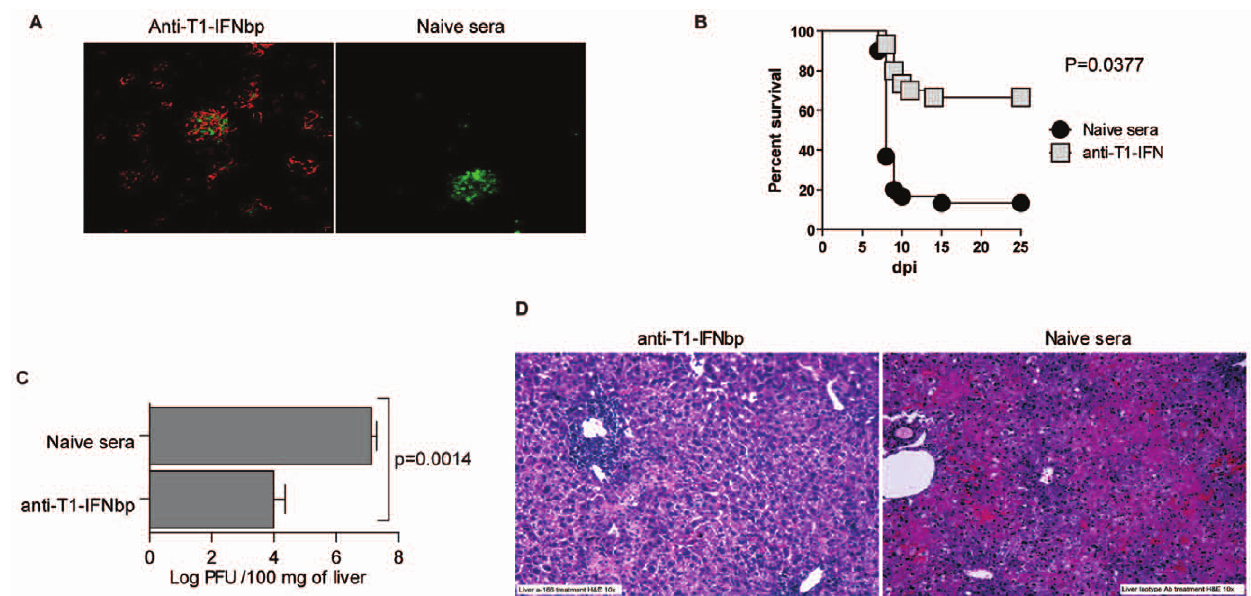
Figure 4. T1-IFNbp Abs bind to cells in and surrounding infected foci in vivo and cure mice from lethal mousepox. A ) Mice were infected with 100 PFU ECTV-Luc. At 5 dpi they were treated with 200 m l ( , 30 mg/ml protein) anti-T1-IFNbp or naı¨ve sera. 16 h later the livers were harvested and stained with anti-rabbit IgG (red) and anti-luc (green). B ) BALB/c mice were infected with 100 PFU of WT ECTV in the footpad. At 5 dpi, mice were treated i.p. with 200 m l rabbit antisera to the T1-IFNbp or, as a control, with naı¨ve sera on the day of infection and monitored for survival. Data are representative of three similar experiments with groups of 10 mice. P values are vs. naı¨ve sera. C ) BALB/c mice were infected with WT ECTV. At 5 dpi they were treated with 200 m l anti-T1-IFNbp rabbit sera. Livers were harvested 2 dpt and virus loads determined by plaque assay. Graph shows the mean + / 2 SEM for 5 individual mice/group and two independent experiments. D ) As in C but livers sections stained with H&E. Data are representative of five mice/group and two independent experiments.